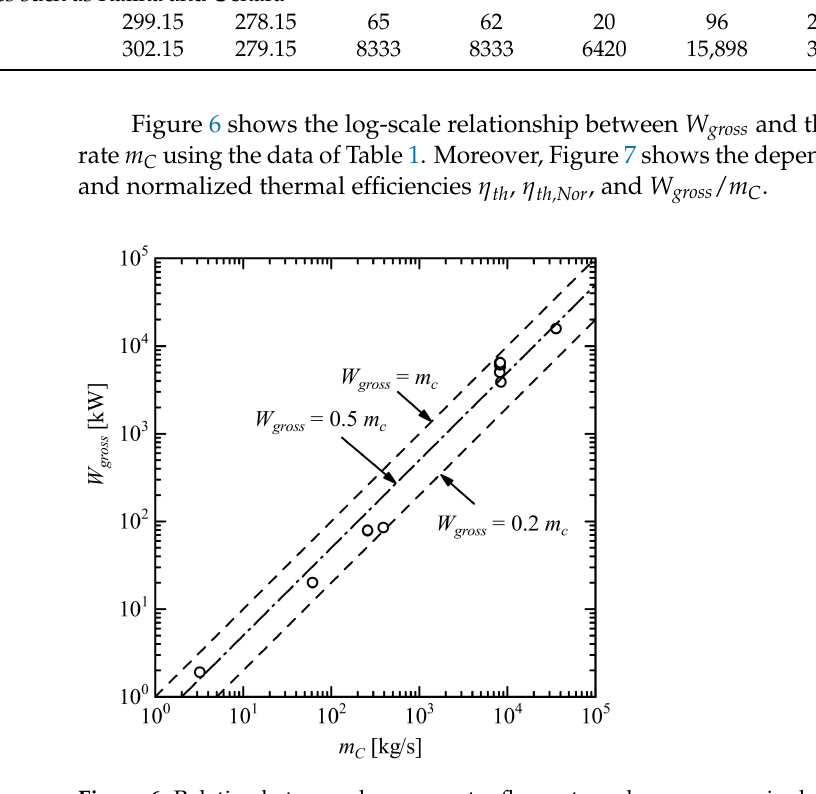
Figure 6. Relation between deep seawater flow rate and gross power in design. The gross power is roughly proportional to the mass flow rate of deep